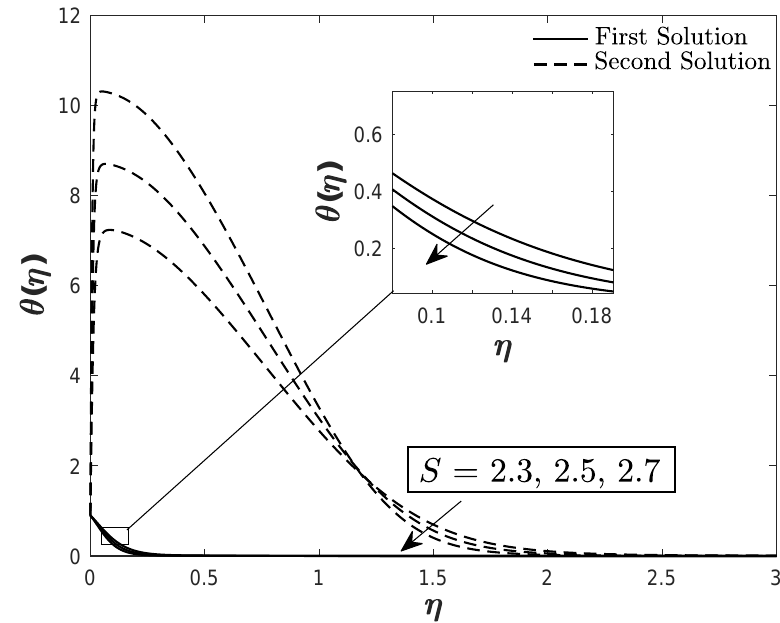
Figure 6. Effect of suction S on the temperature profile.